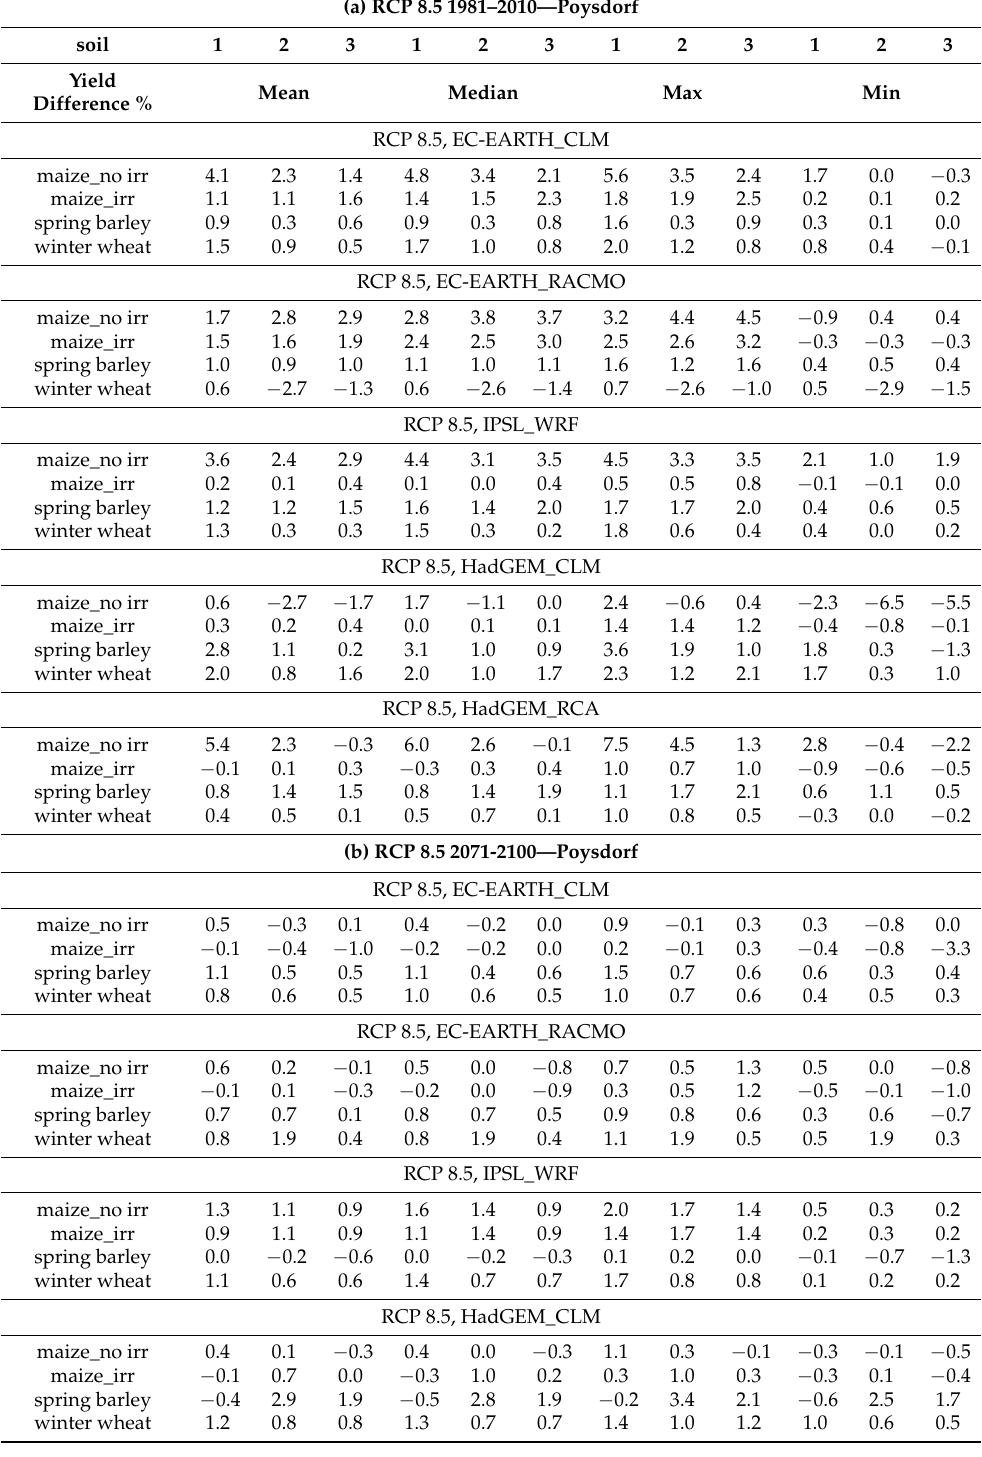
Table A6. Mean, Median, Maximum (Max), and Minimum (Min) values for yield differences (%) across 5, 11, and 21 km aggregated data in maize (rainfed = no irr, optimally irrigated = irr), winter wheat, and spring barley (rainfed) grown on three different soils; 1 km input data vs. aggregated data of five ÖKS15 projections in RCP 8.5 (EC-Earth_CLM, EC-Earth_RACMO, IPSL_WRF, IPSL_RCA and HadGEM_RCA) in Poysdorf, Bad Gleichenberg and Kremsmünster for the (a) baseline